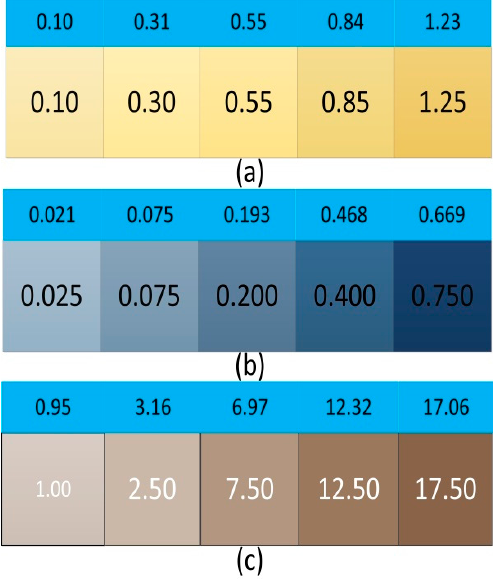
Figure 15. Measurement results of standard solution for ammonia nitrogen, phosphate, and chloride. ( a ) is the measurement results of standard solution for ammonia nitrogen. ( b ) is the measurement results of standard solution for phosphate. ( c ) is the measurement results of standard solution for